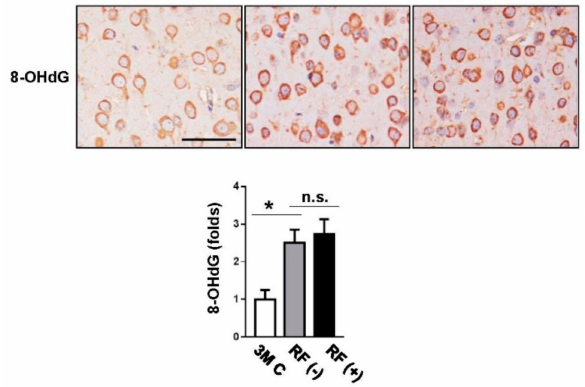
Figure 2. Effects of RF-EMF exposure on the protein expression levels of 8-hydroxy-2 (cid:48) -deoxyguanosine (8-OHdG) as determined by histological analysis. Representative images of DNA damage in the sham-exposed (RF ( − ), n = 6) and 8-month RF-exposed (RF (+), n = 6) mouse brain. The expression of 8-OHdG was examined by immunohistochemical staining ( upper panel ) and subsequent quantification ( lower panel ). Both sham-exposed and RF-exposed groups showed increased 8-OHdG expression compared with that in young-aged controls (3M C, n = 3). Scale bar: 50 µ m. The values are presented as means ± SEM. * p < 0.05 versus young-aged (3M C) group. n.s.: no